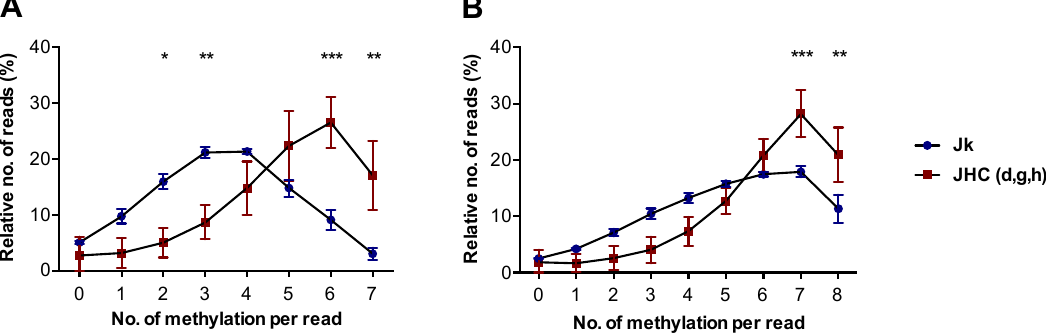
Figure 4. Assessment of methylation heterogeneity of CpG1 island on SHP-1 P2 in cell lines by NGS-BS. The methylation percentages of individual reads for Jurkat (Jk) and JHC cell lines were plotted as ratio of analyzed reads versus number of total methylations per read. ( A ) Relative number of bisulfite sequencing reads per number of methylations generated by forward primer corresponding to CpG site 1 to 7. ( B ) Relative number of bisulfite sequencing reads per number of methylations generated by reverse primer corresponding to CpG site 4 to 11. Data are presented as mean ± SD of two paired-end NGS runs. For the C protein expressing cells, data are represented as sum of the averages of JHC.d, JHC.g and JHC.h clones (JHC.d, JHC.g, JHC.h = JHC) . The statistical comparisons of methylation levels were performed by two-way ANOVA and Sidak’s multiple comparison test. Points with stars are statistically significant with adjusted p values; * p < 0.05, ** p < 0.01 and *** p < 0.001.